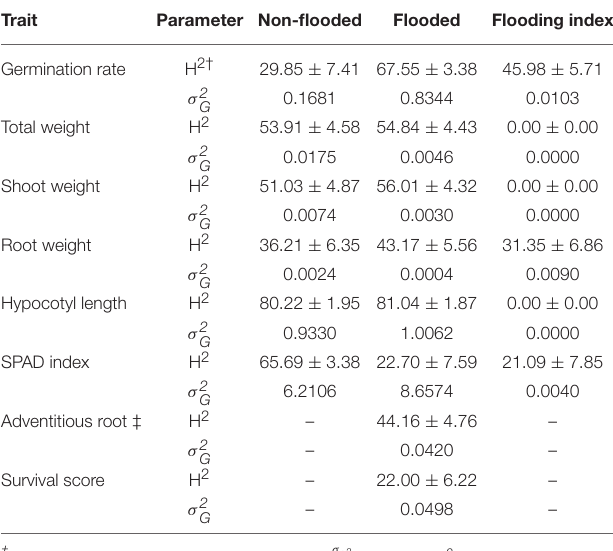
TABLE 3 | Broad-sense heritabilities and genetic variances of traits. Trait Parameter